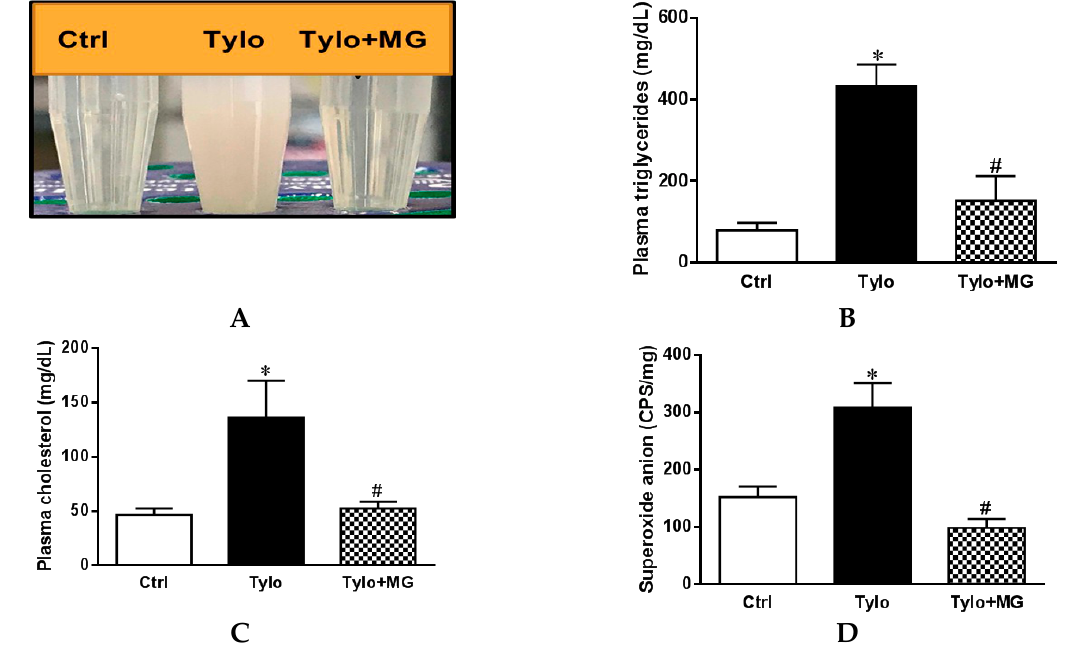
Figure 1. Effects of magnolol (MG) treatment on plasma lipid profiles and hepatic superoxide anion in tyloxapol (Tylo)-injected rats. ( A ) Plasma levels of triglyceride (TG); ( B ) macroscopic photograph of plasma; ( C ) plasma levels of cholesterol (TC); ( D ) superoxide anion formation. Data are expressed as mean ± SEM, n = 5–12. * p < 0.05 vs. Ctrl; # p < 0.05 vs. Tylo (tyloxapol).